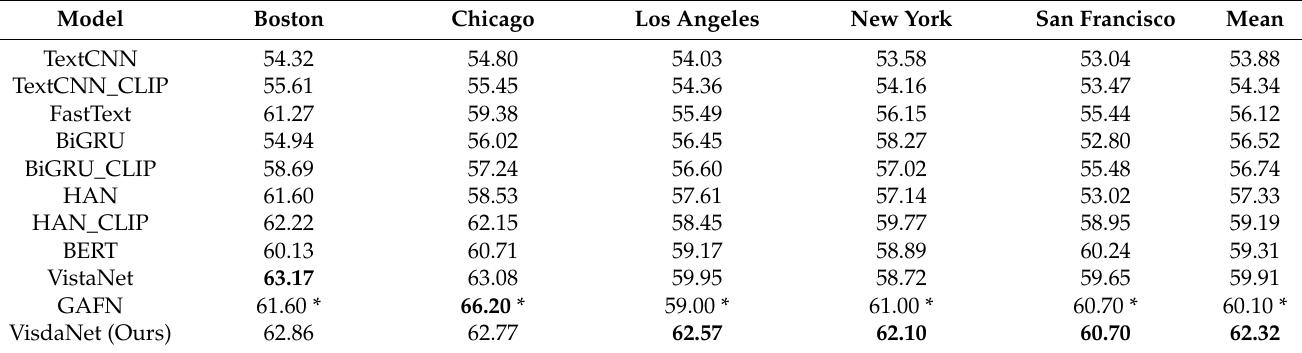
Table 6. Performance comparison to baselines on the Yelp restaurant review dataset